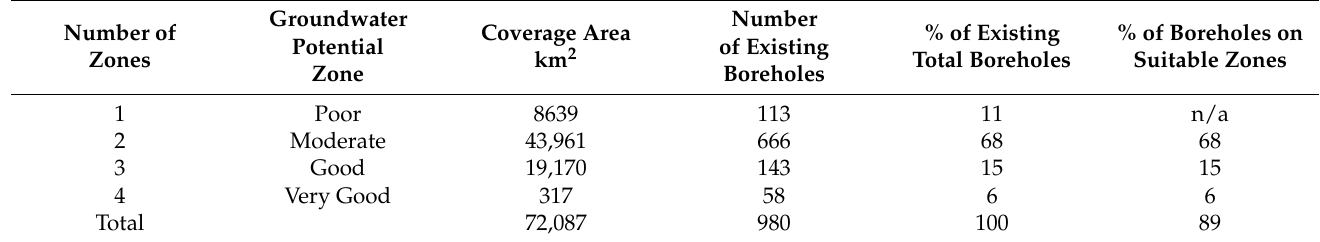
Table 5. Number of boreholes on suitable groundwater potential